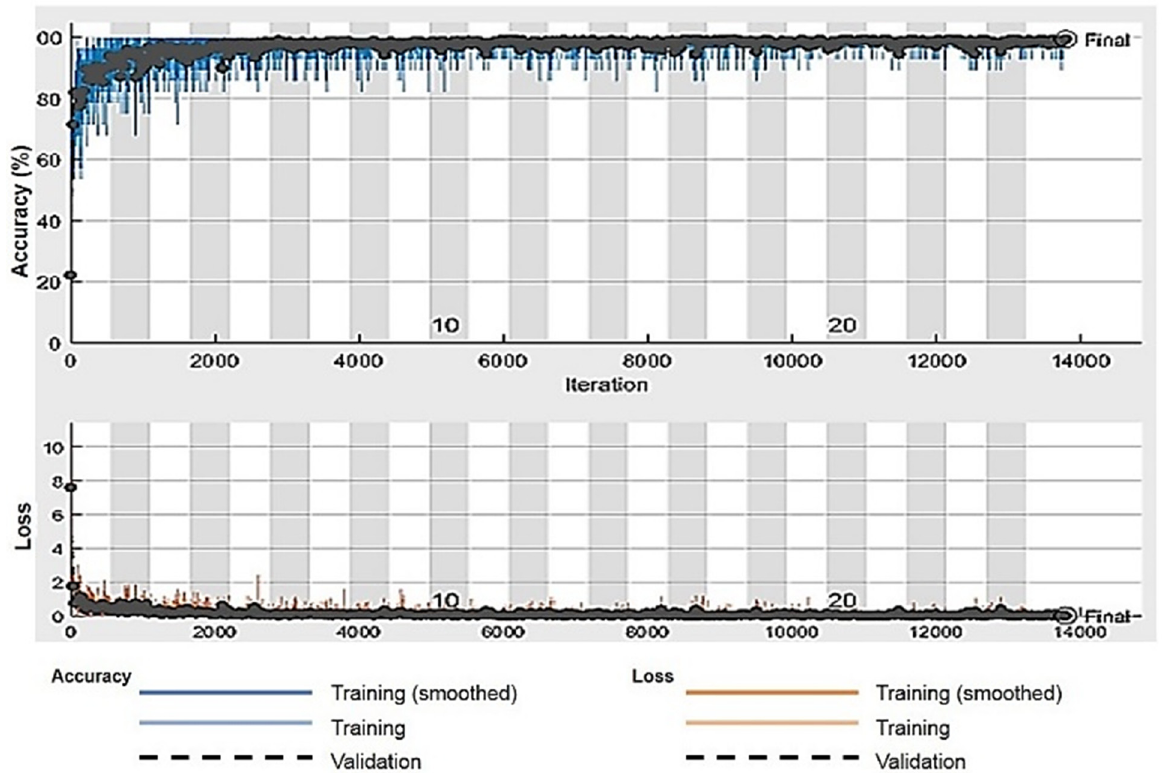
Figure 7. Plot of accuracy and loss for validation.